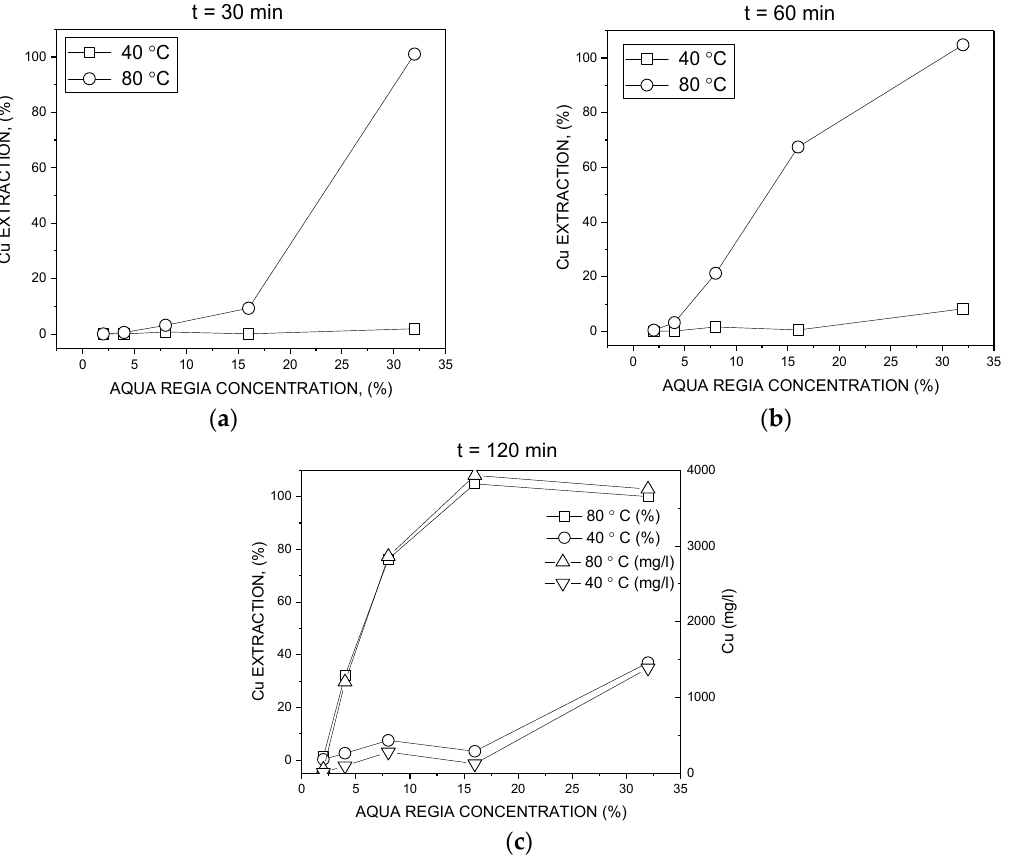
Figure 5. The extractions of copper at t = 30 min ( a ); t = 60 min ( b ); and t = 120 min ( c ). Extraction presented as % at left y -axis ( a – c ) and mg/L at right y -axis ( c ).